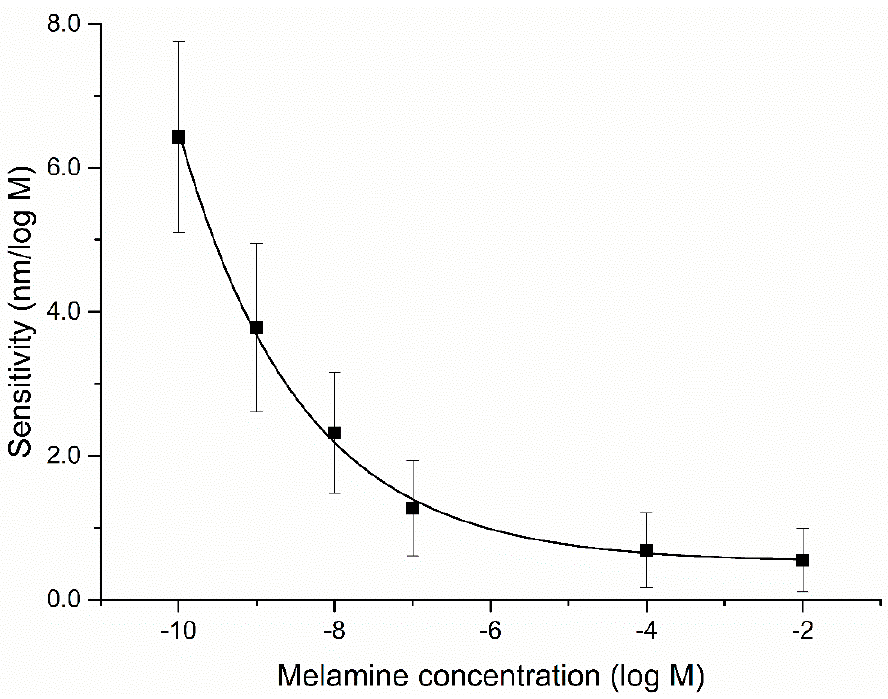
Figure 6. Sensitivity of PoAP–MEL OF-SPR probe for the detection of melamine solution with concentration ranging from 0 M to 10 − 2 M.